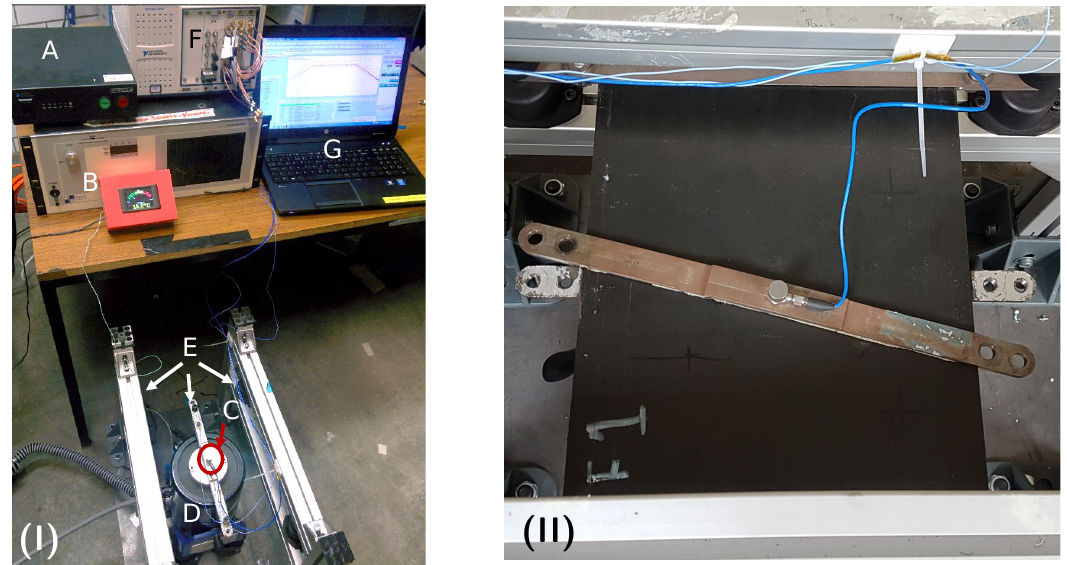
Figure 5. ( I ) Vibration set-up: (A) controller, (B) shaker power amplifier, (C) control accelerometer, (D) shaker, (E) fixture, (F) signal acquisition and generator system (G) workstation; ( II ) close up of the plate